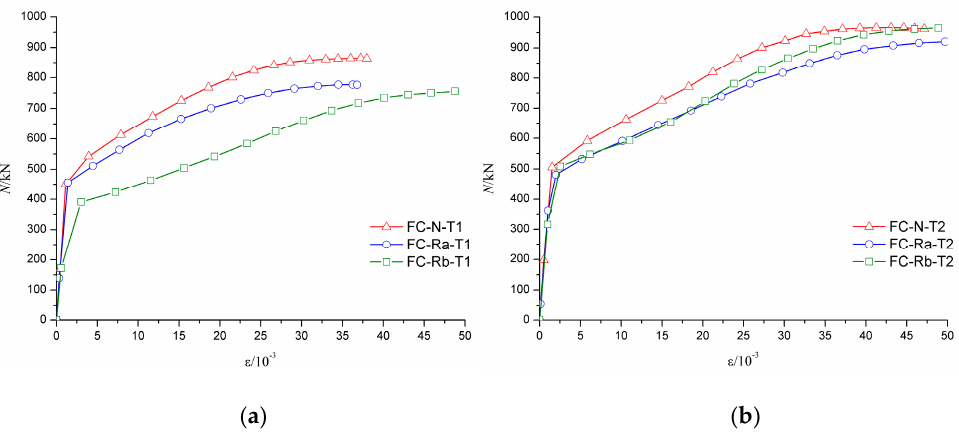
Figure 23. Influence of concrete material on N- ε curves. ( a ) The wall thickness of steel tube is 4 mm; ( b ) The wall thickness of steel tube is 5 mm.